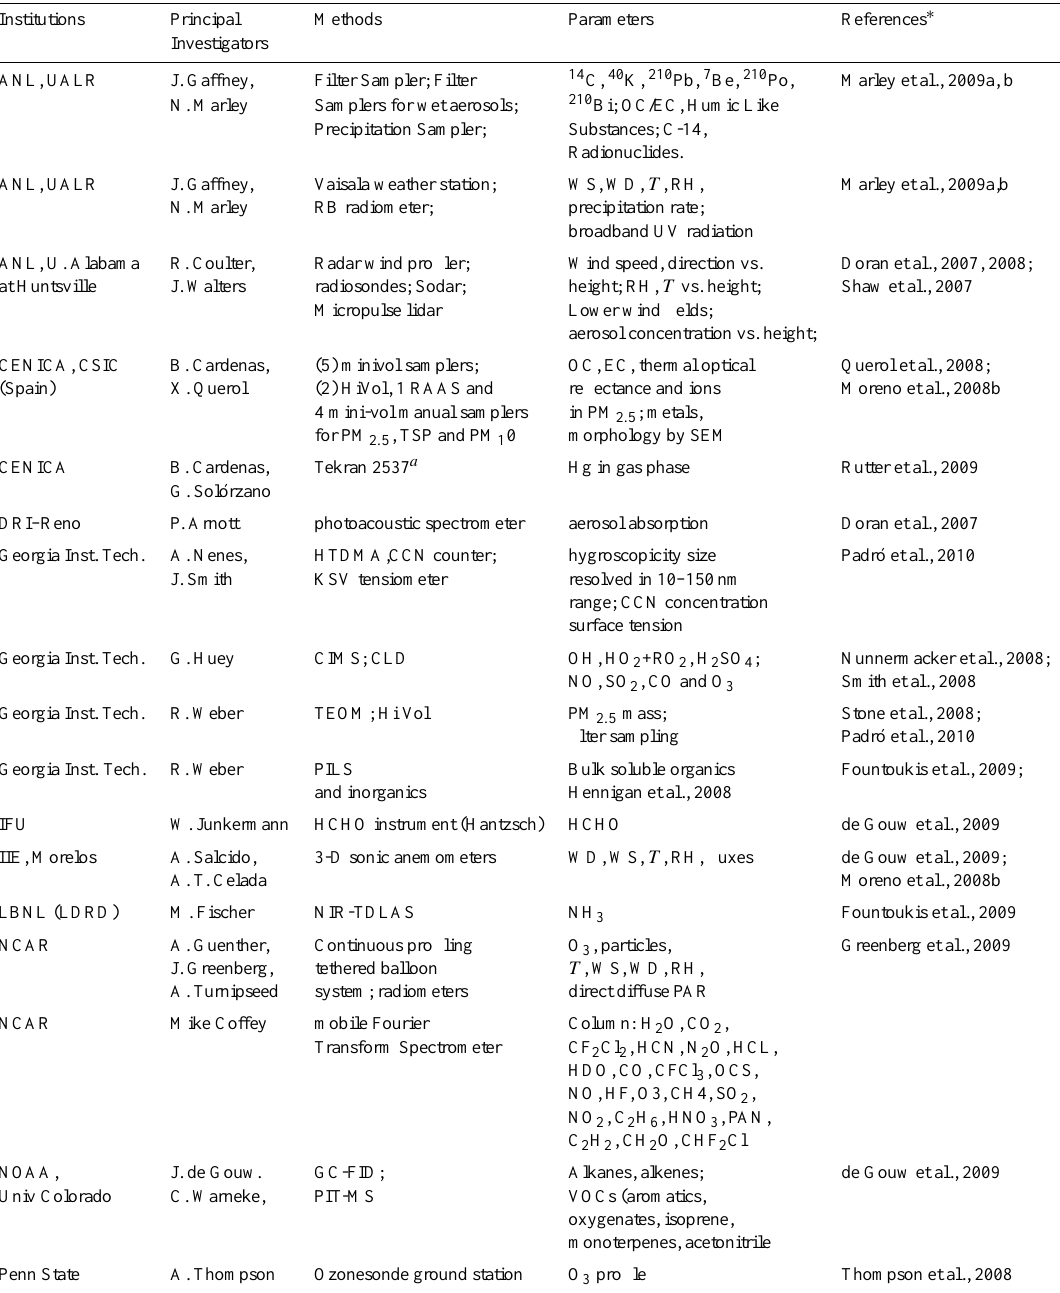
Table 2. List of participating institutions and instruments deployed at the T1 site.